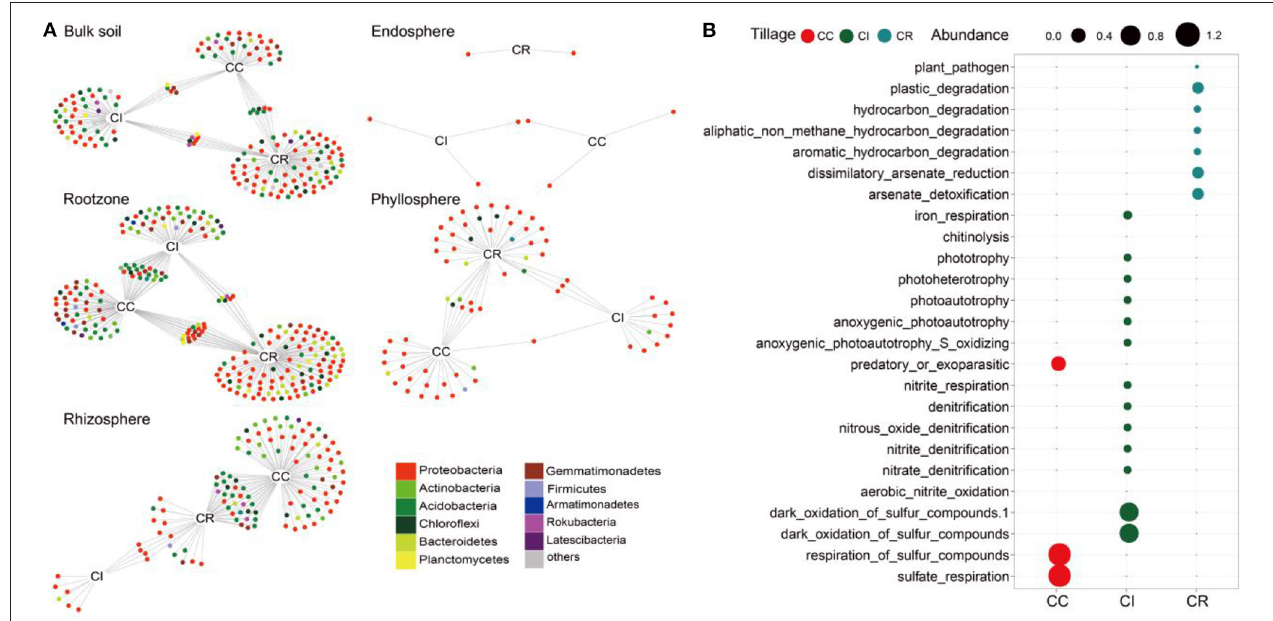
FIGURE 2 | Indicator species analysis results of bacterial community in soil-plant continuous chamber under continuous cropping, intercropping and crop rotation. (A) Bipartite networks display cropping systems specific ASVs in the soil-plant continuum compartments bacterial communities as determined using indicator species analysis. ASVs are colored according to their Phylum assignment. (B) Bubble diagram showing that FARPROTAX predicted the relative abundance of ecosystem functions of ASVs sensitive to continuous cropping (CC), intercropping (CI), and crop rotation (CR) systems. Circles represent individual bacteria ASVs that are positively and significantly associated ( p < 0.05) with one or more of the cropping systems [association(s) given by connecting